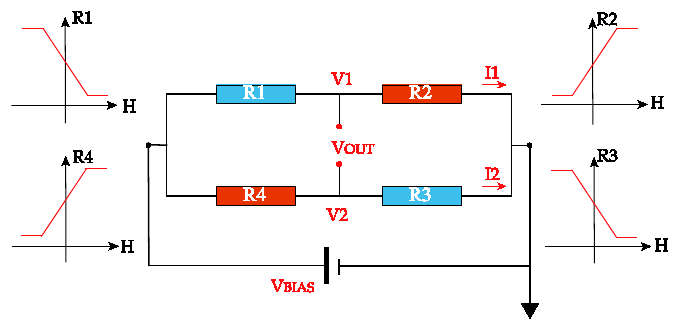
Figure 1. Schematic of a full bridge GMR sensor. It exhibits a null output in the absence of a signal field and offers an intrinsic compensation for thermal drift. When an external field H is applied, the bridge has a linear output. R 1,3 (H) = R − (cid:52) R(H); R 2,4 (H) = R + (cid:52) R(H); V out = V bias * ∆R/R .